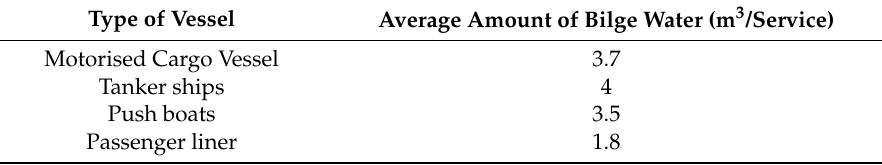
Table 1. Average amount of bilge water for different types of